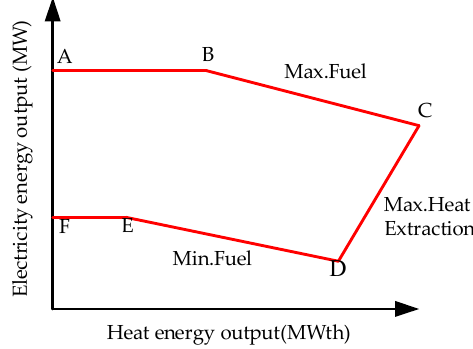
Figure 2. Feasible operation region of the combined heat and power (CHP) units.